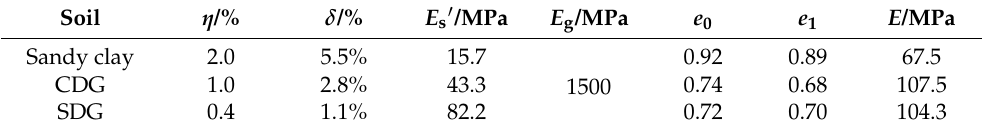
Table 4. Parameters of the reinforcement of different soil layers.